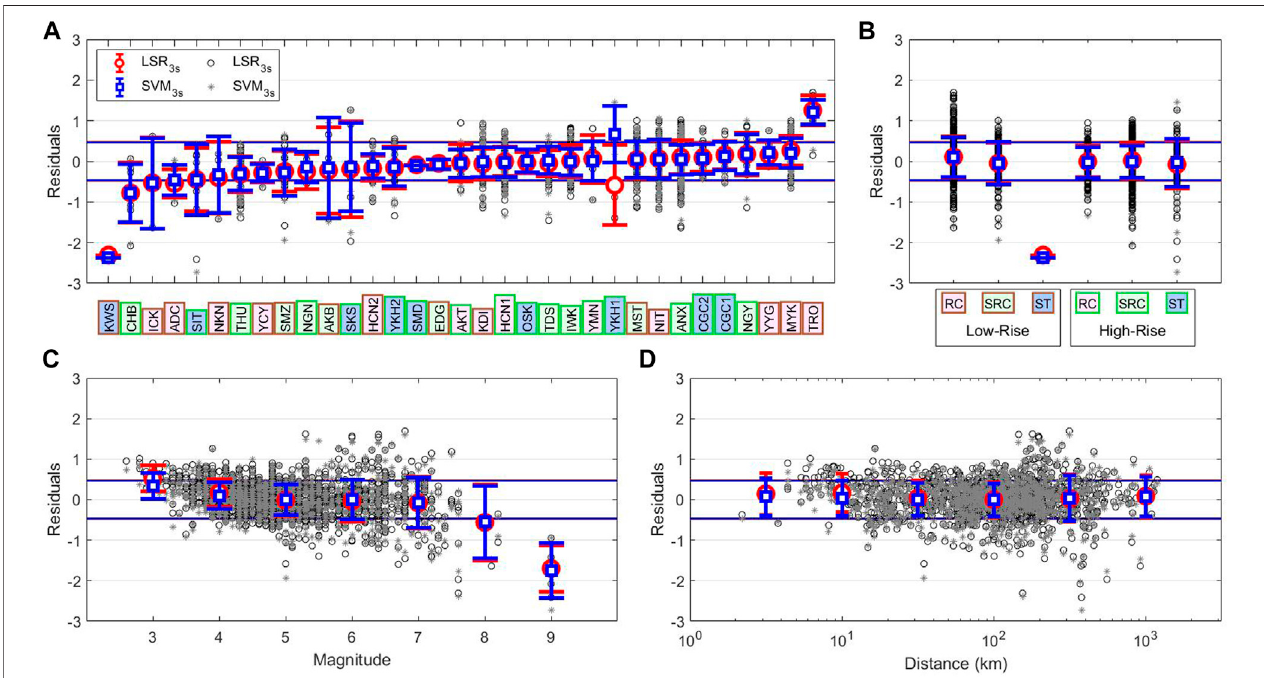
FIGURE 5 | Decomposition ofthe residuals of Dr. prediction for Japanese test set. The residuals are computed as real Dr. - predicted Dr., so positive values mean overestimation, and negative residuals mean underestimation. In each panel we show the residuals for two different models: LSR 3s with circles representing the single prediction and red errorbars representing the mean prediction of the group; SVM 3s with stars for the single prediction and blue errorbars for the group mean. Red and blue lines represent the ± σ train for LSR 3s and SVM 3s , respectively. The labels in panels (A) and (B) are colored by construction type and height: pink for RC; light green for SRC; blue for ST; brown edges for low-rize; green edges for high-rize. In panel (A) we decompose the residuals by buildings. In (B) we group them by building type of construction and height. In panel (C) we use the magnitude to decompose residuals, the groups are evenly spaced and the errorbars are placed in the center of the bin. In panel (D) the residuals are grouped by distance in km, the groups are evenly spaced and the errorbars are placed in the center of the bin.